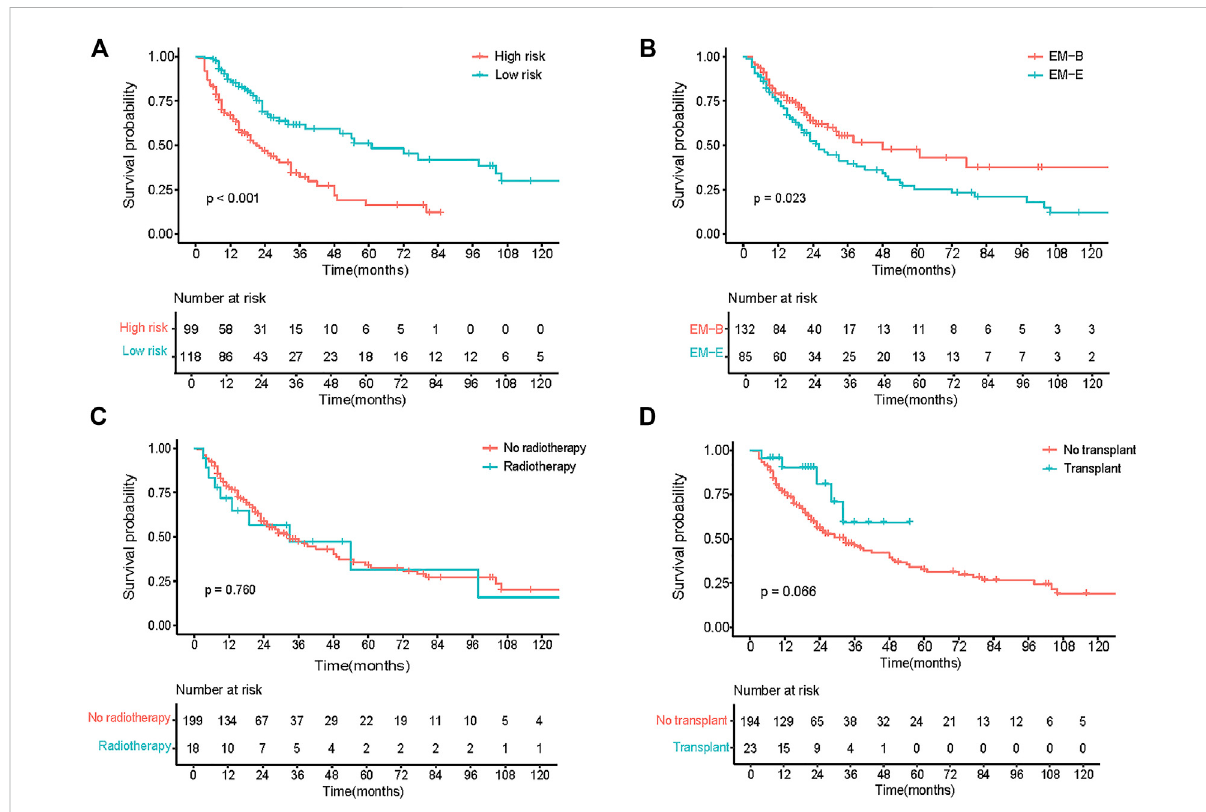
FIGURE 5 PFSofpatientsaccordingtodifferentstrati fi cation. (A) Survivalcurvesofriskstrati fi cationbasedonourmodel(HighriskvsLowrisk). (B) Survival curvesofdifferentgroups(EM-BvsEM-E). (C) Survivalcurvesofdifferenttreatment(NoradiotherapyvsRadiotherapy). (D) Survivalcurvesofdifferent treatment (No transplant vs